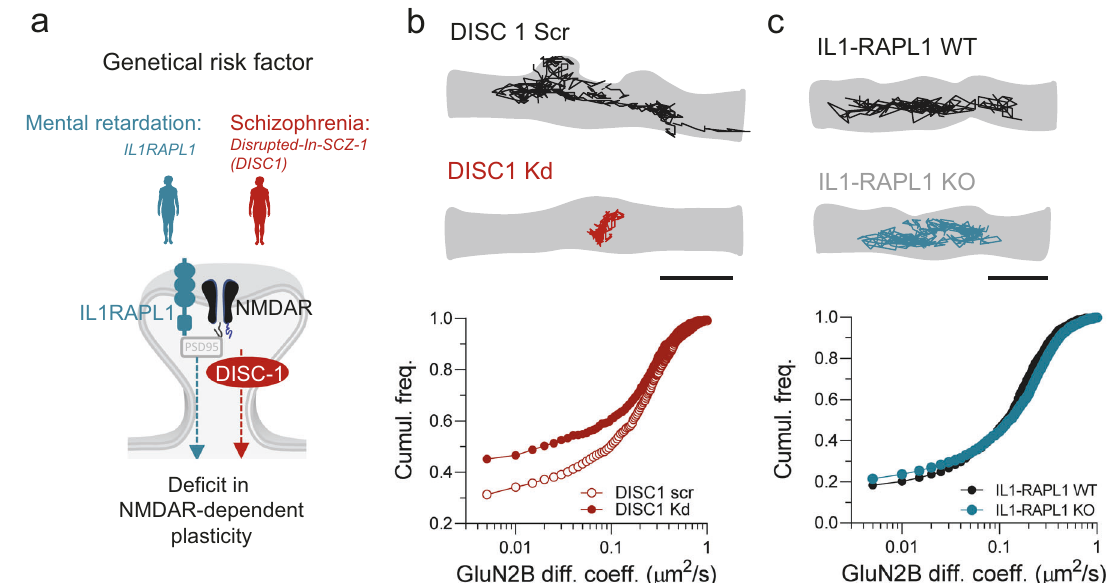
Fig. 3 DISC1 downregulation alters NMDAR surface dynamics. a Schematic description of the experimental work fl ow: we compared the GluN2B-NMDAR surface dynamics onto neurons in which we downregulated either IL1RAPL1 or DISC1. b Representative trajectories (50 ms acquisition) of surface GluN2B-NMDAR-QD complexes on neurons transfected with either a scrambled siRNA (DISC1 Scr) or DISC1 siRNA (DISC1 Kd). Scale bar = 300 nm. Below , Cumulative distributions of synaptic GluN2B-NMDAR instantaneous diffusion coef fi cient (µm 2 /s) in DISC1 Scr and DISC1 Kd (Scr, n = 976 trajectories; Kd, n = 662; *** p < 0.0001, Kruskal – Wallis followed by Dunn ’ s multiple comparison test). c Representative trajectories (50 ms acquisition) of surface GluN2B-NMDAR-QD complexes on neurons from IIL1RAPL1 wild-type or KO mice. Scale bar = 300 nm. Below , Cumulative distributions of synaptic GluN2B-NMDAR instantaneous diffusion coef fi cient (µm 2 /s) in WT and KO conditions (WT, n = 1430 trajectories; KO, n = 1097; p >